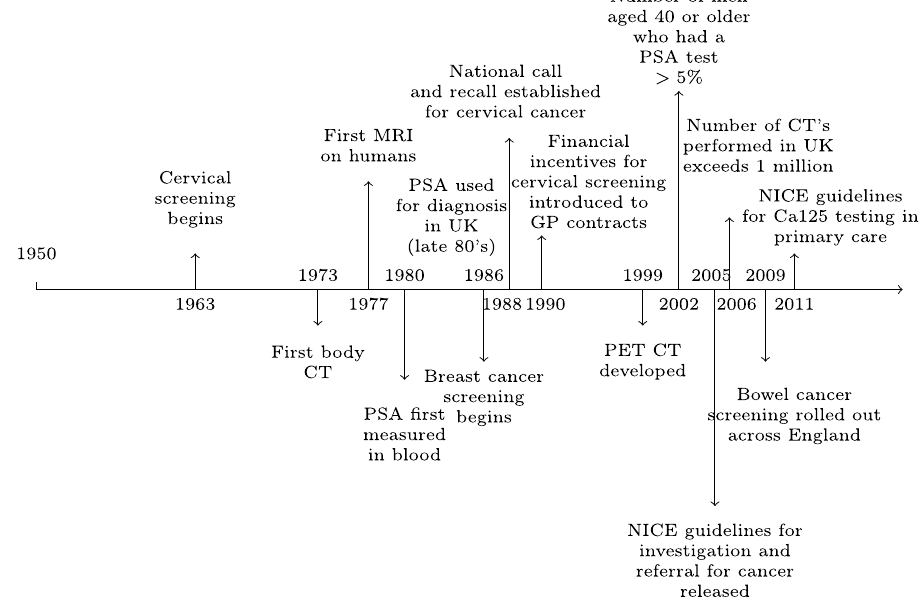
Figure 1. Timeline showing important “milestones” in cancer diagnostic practice in the UK.